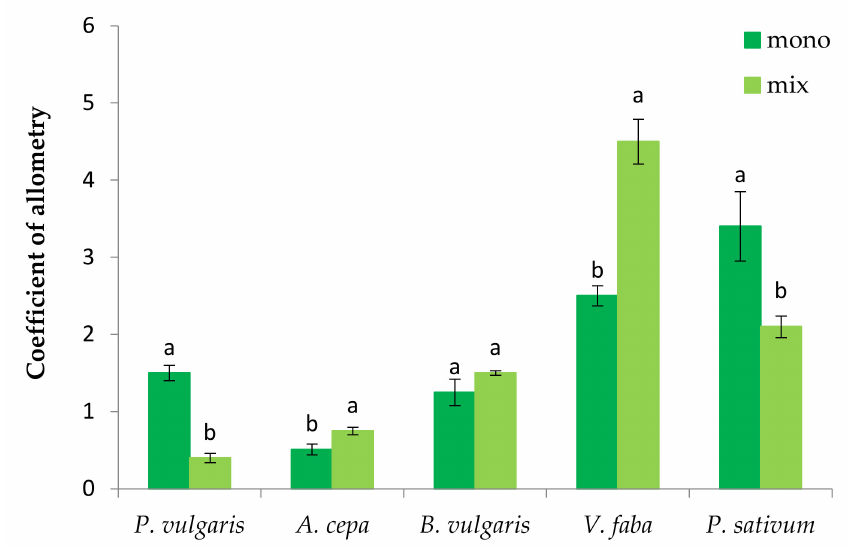
Figure 5. Coefficient of allometry of crop species grown together with P. oleracea seeds (mono = only crop plant; mix = crop grown together with P. oleracea ). Bars represent the means of 4 replicates ± SE. Bars topped by the same letter indicate no significant difference between treatments at the 5% level using Duncan’s multiple-range